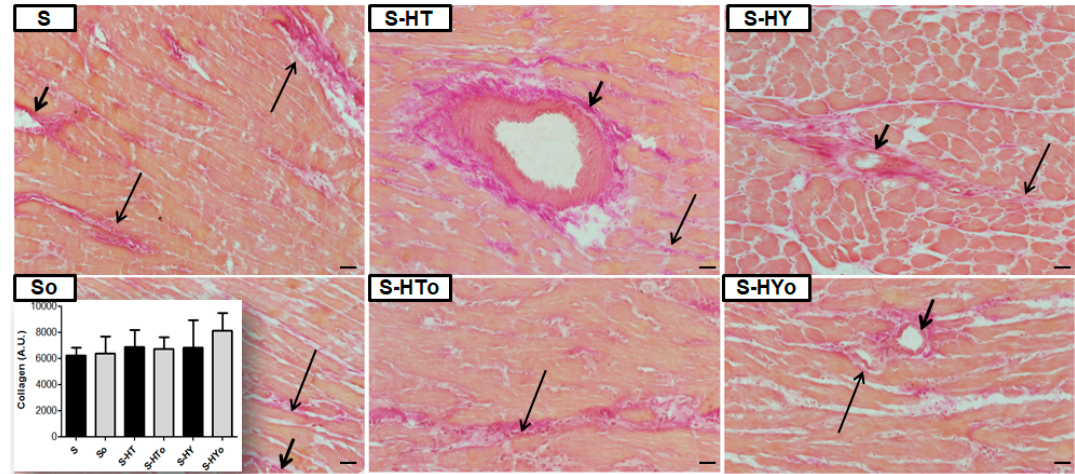
Figure 9. Representative images of van Gieson staining and quantitative analysis of collagen deposition in the male normotensive rats with altered thyroid status, fed with or without Omacor. Interstitial fibrosis—long arrows; Perivascular fibrosis—short arrows. W—Wistar Kyoto euthyroid control rats; o—fed with Omacor; HT—hyperthyroid rats; HY—hypothyroid rats. Objective 40×. Scale bar 10 µm. Data are presented as means ± SD; * p < 0.05 vs. W; # p < 0.05 untreated vs. treated with Omacor.